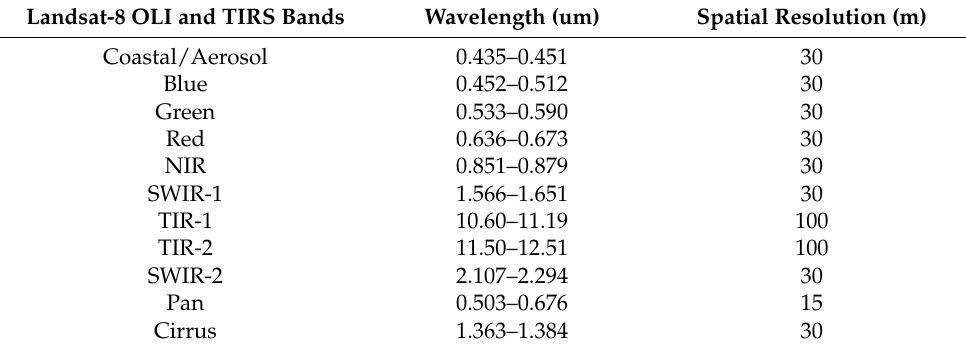
Table 1. Spectral band spatial resolution and wavelength of the Landsat-8